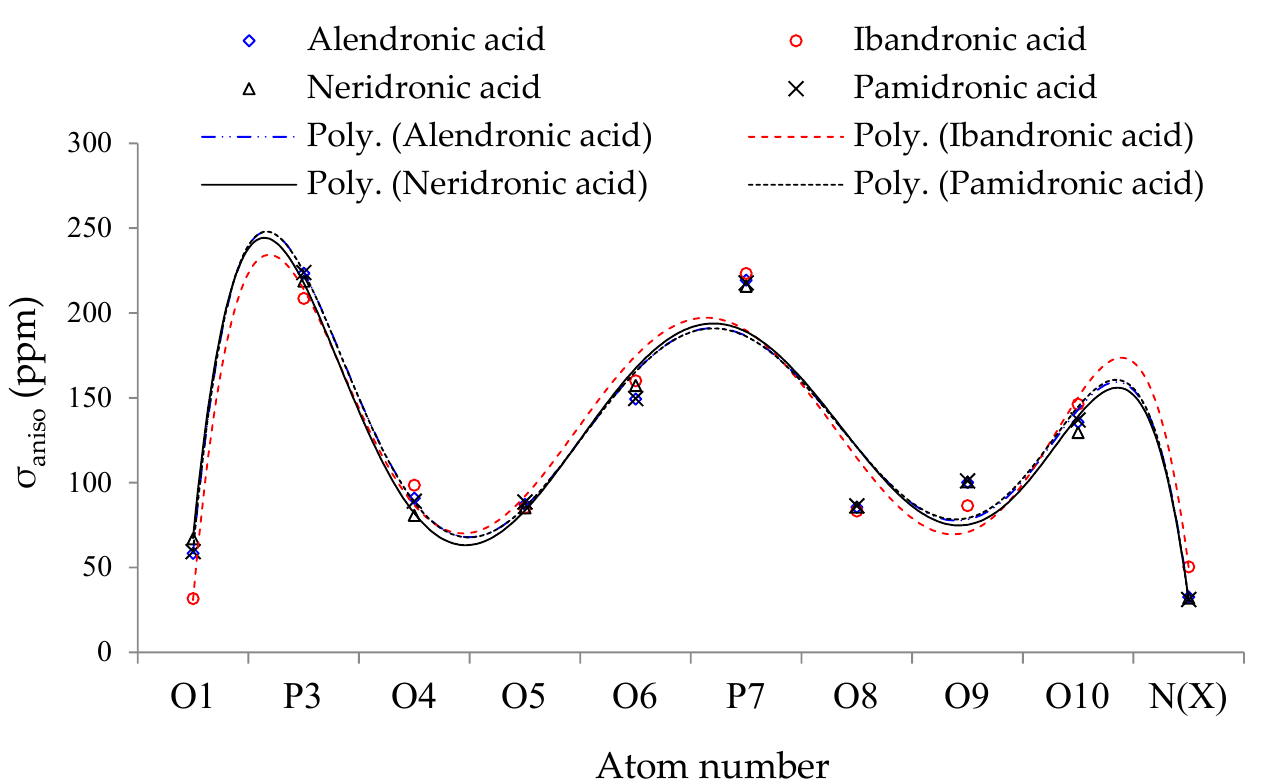
Figure 2. Calculated σ aniso of oxygen, nitrogen, and phosphorus atoms for alendronic acid, ibandronic acid, neridronic acid, and pamidronic acid in ppm conjugated on (6, 6) armchair using B3LYP/6-311+G(2d,p) level of theory.